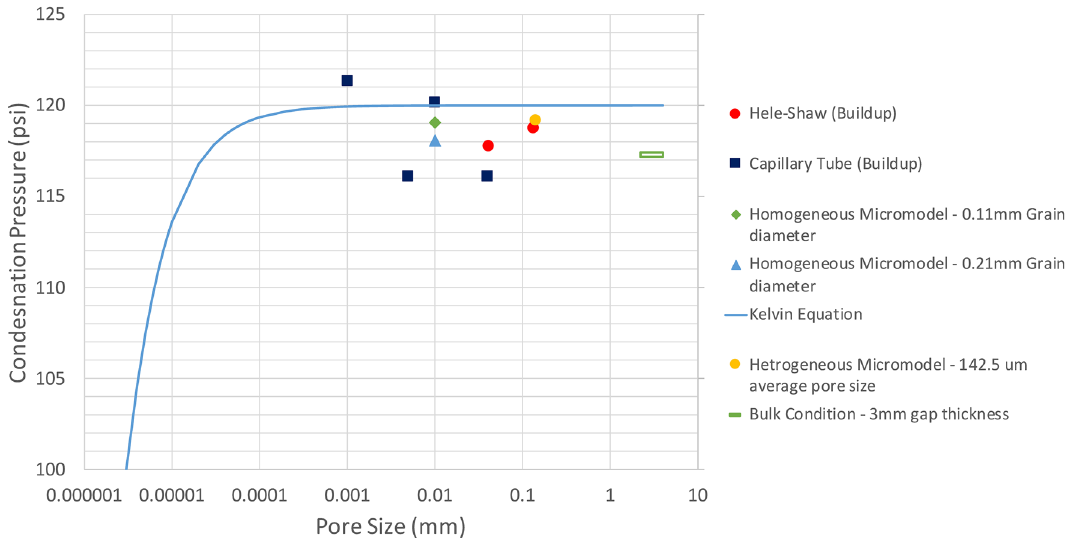
Figure 12. Condensation pressures of propane in Hele–Shaw cells and micromodels during the pressure build-up process. Each point for the bulk condition represents the average of 3 trials, and each point for the Hele–Shaw cell and microfluidic chip represents the average of 2 trials. All the pressure values in this figure were measured at 20 °C (293.15